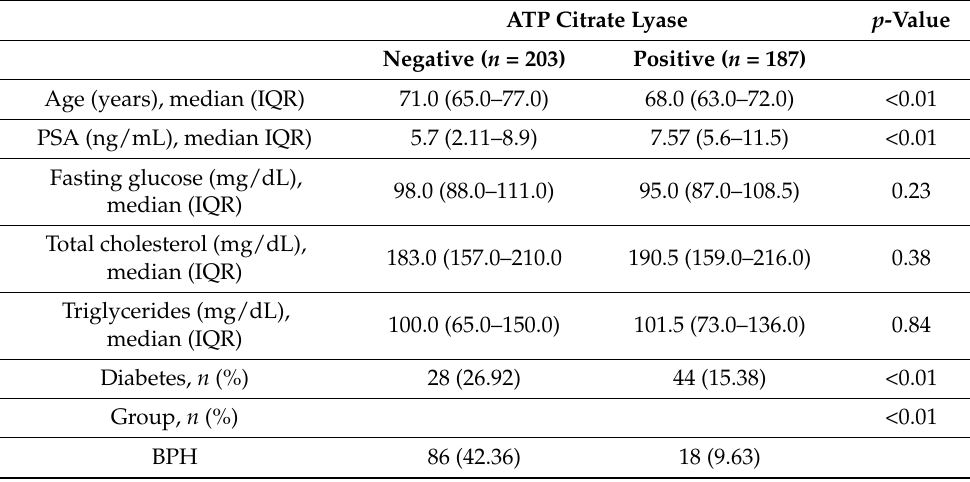
Table 1. ATP citrate lyase expression according to IHC